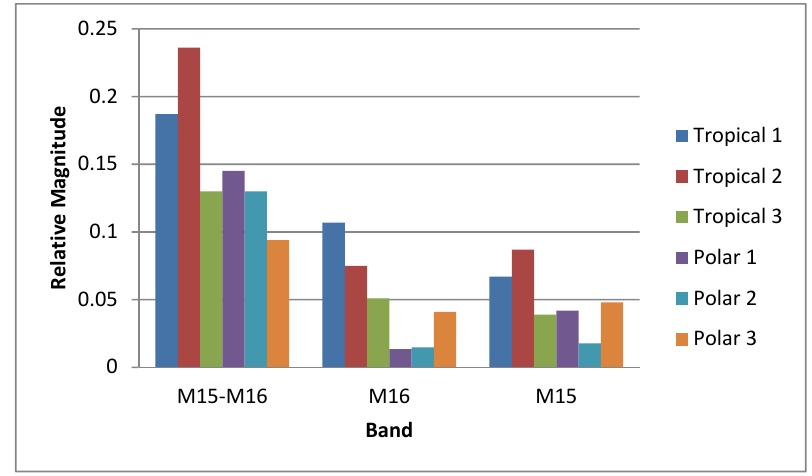
Figure 7. Comparison of the relative magnitude ( i.e. , ratio of brightness temperature variation magnitude to temperature range) over tropical and polar region.